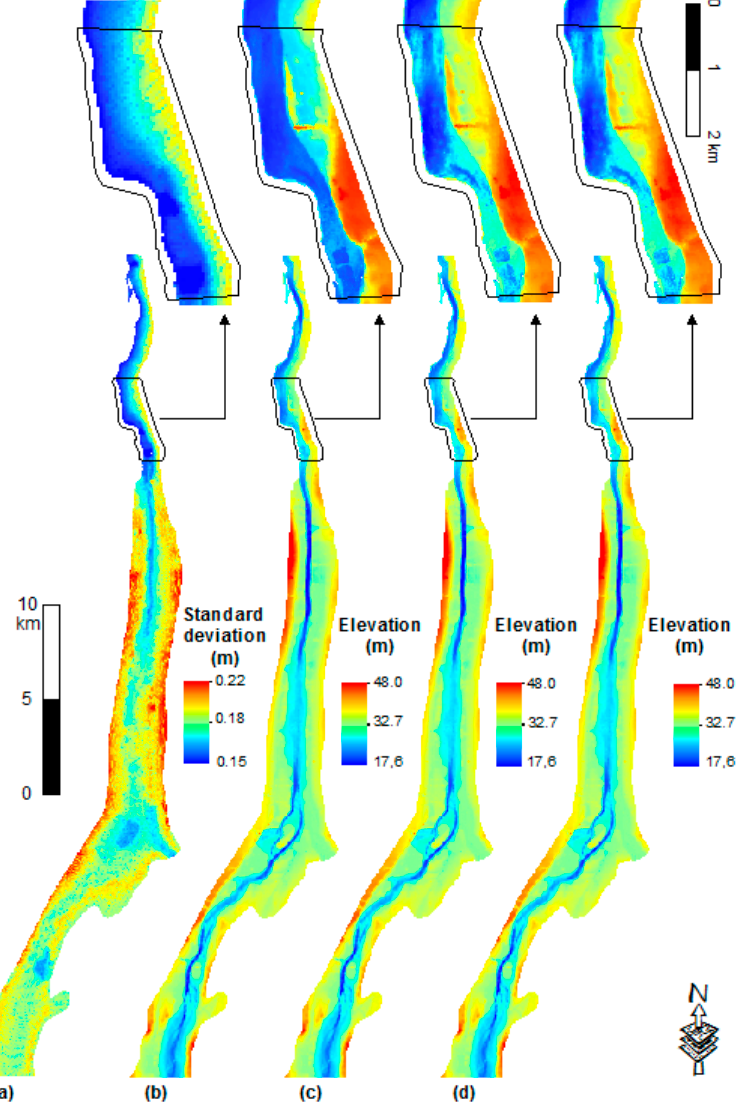
Figure 3. Three realizations of the random field of the topography error: Mean error ( a ), lower topography scenario ( b ), nominal (mean) topography model ( c ), and upper topography scenario ( d ).